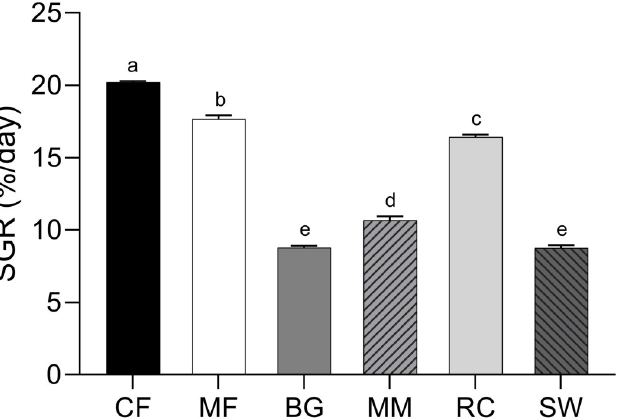
Fig 2. Mean ± standard error (n = 3) of specific growth rate (SGR, %/day) of black soldier fly larvae during the 7-day trial on six different rearing substrates: Chicken feed (CF), mixed feed (MF), brewer’s spent grain (BG), mitigation mussels (MM), rapeseed cake (RC), and shrimp waste (SW). Dissimilar lower case superscript letters represent significant differences (p < 0.05) between means. SGR (%/day) = (ln (final body weight (g))—ln (initial body weight (g)))/time of trial (d) � 100.